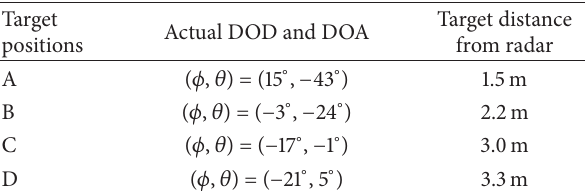
Table 2: Target positions in a radio anechoic